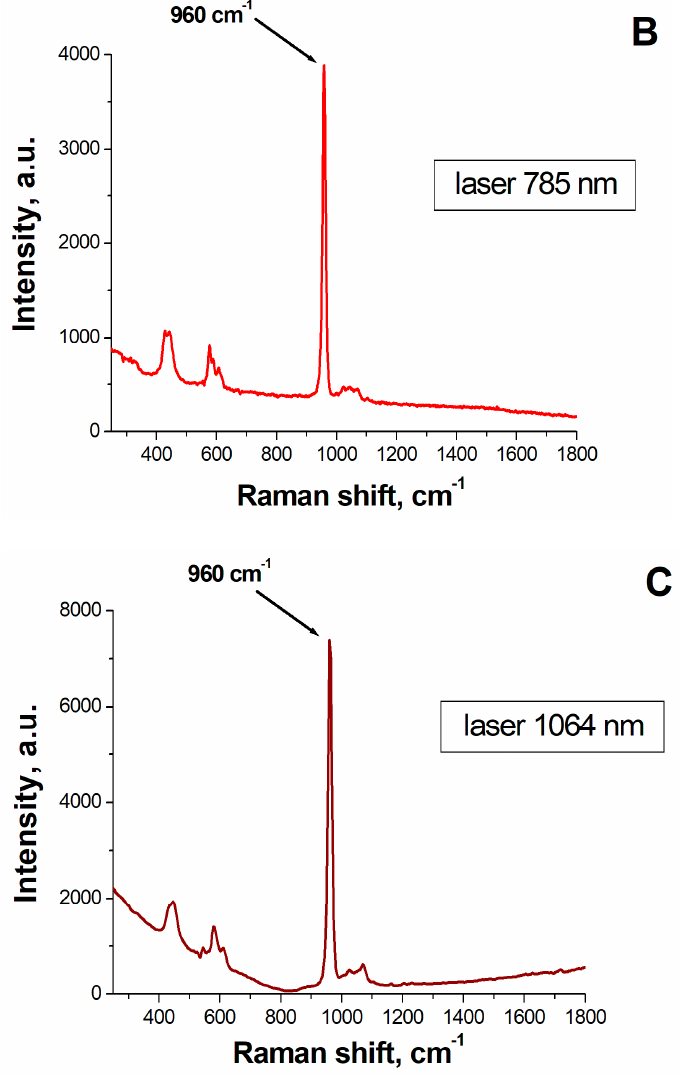
Figure 2. Raman scattering spectra of tooth enamel when excited by laser sources with wavelengths: ( A )-532 nm (exposure time-1 s), ( B )-785 nm (exposure time-2 s), ( C )-1064 nm (exposure time-4 s).